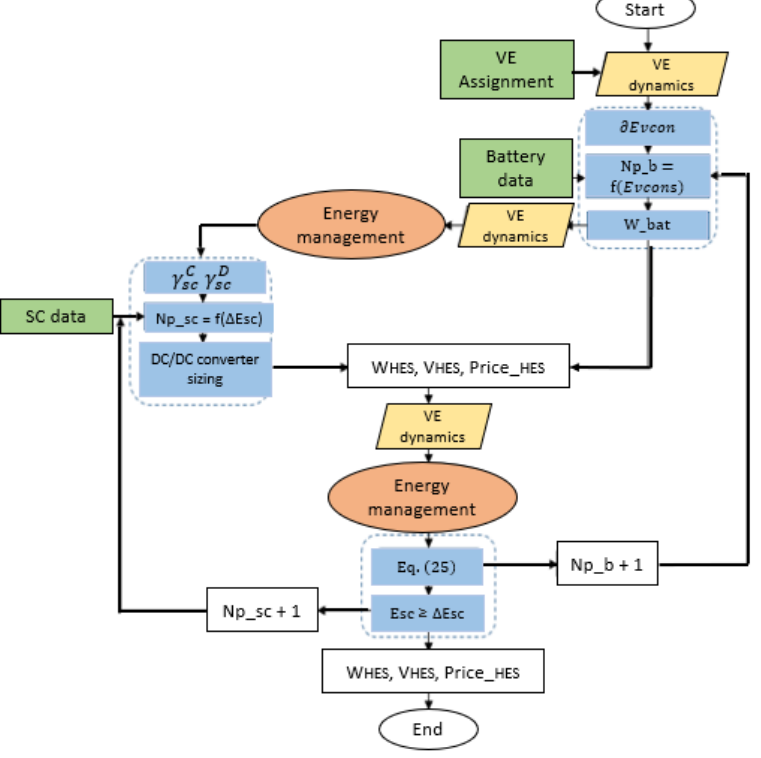
Figure 5. HESS sizing algorithm schematic [37].